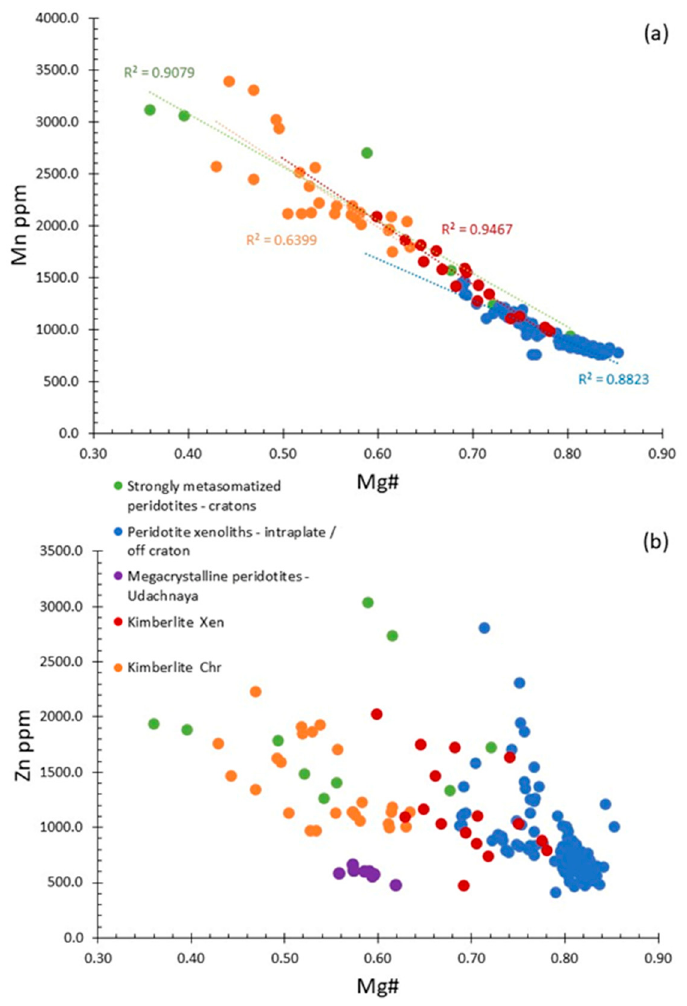
Figure 4. ( a ) Mg# vs. Mn and ( b ) Mg# vs. Zn for the Cr-spinels from this study. Data for peridotite xenoliths [15–18] are shown for comparison. Symbols and colors as in Figure 3.